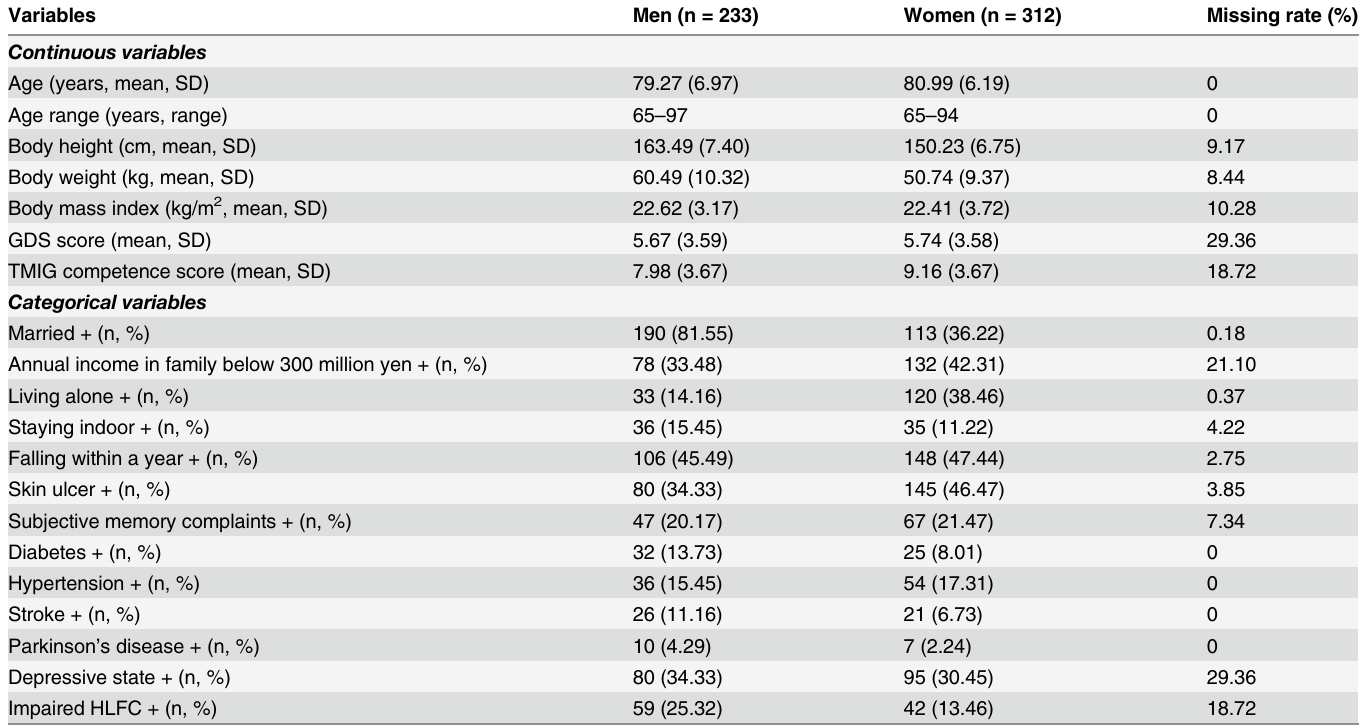
Table 1. Characteristics of